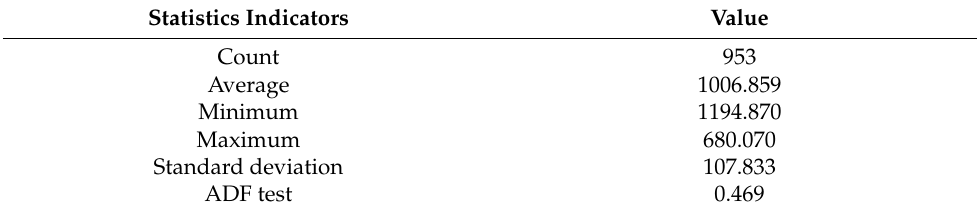
Table 1. Descriptive statistics of the closing